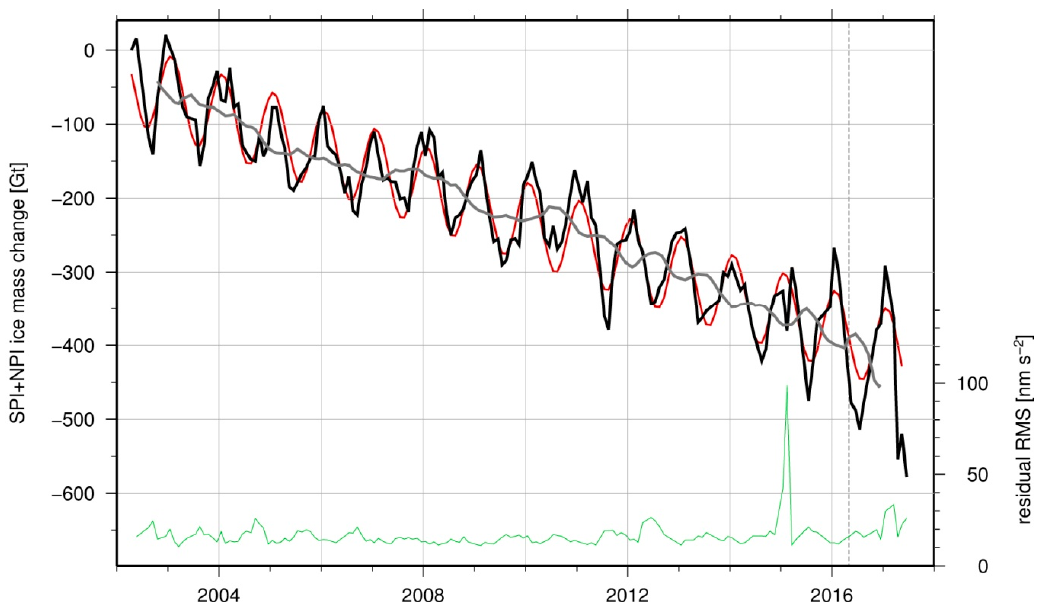
Figure 4. Time series of the ice mass change in the SPI and NPI region. Black: unfiltered time series of monthly relative ice mass change throughout the GRACE data period; red: linear plus periodic (annual and semi-annual) signal fitted to this time series; grey: low-pass filtered time series applying a running annual mean; green: residual root mean square (RMS) of the monthly gravity vectors after the adjustment of the ice mass scale factors. Dashed vertical line marks the month of March 2016, after which the GRACE data quality deteriorates and the monthly ice mass estimates were downweighted in the ice mass change rate determination.